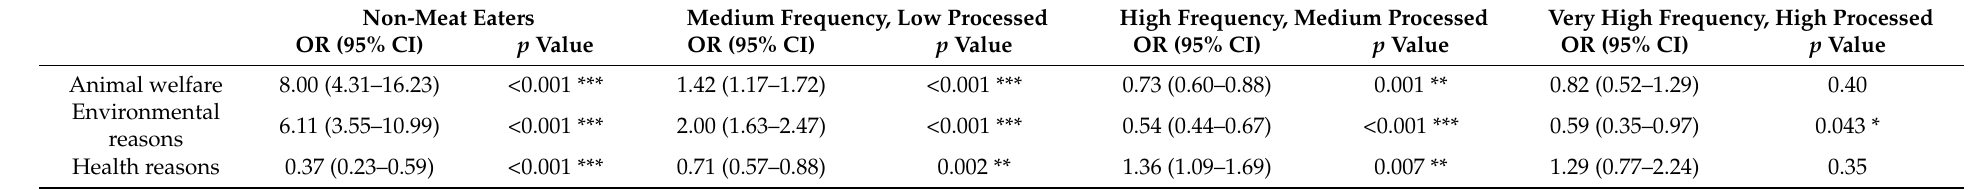
Table 3. Motivational factors that may lead participants to consume less meat.